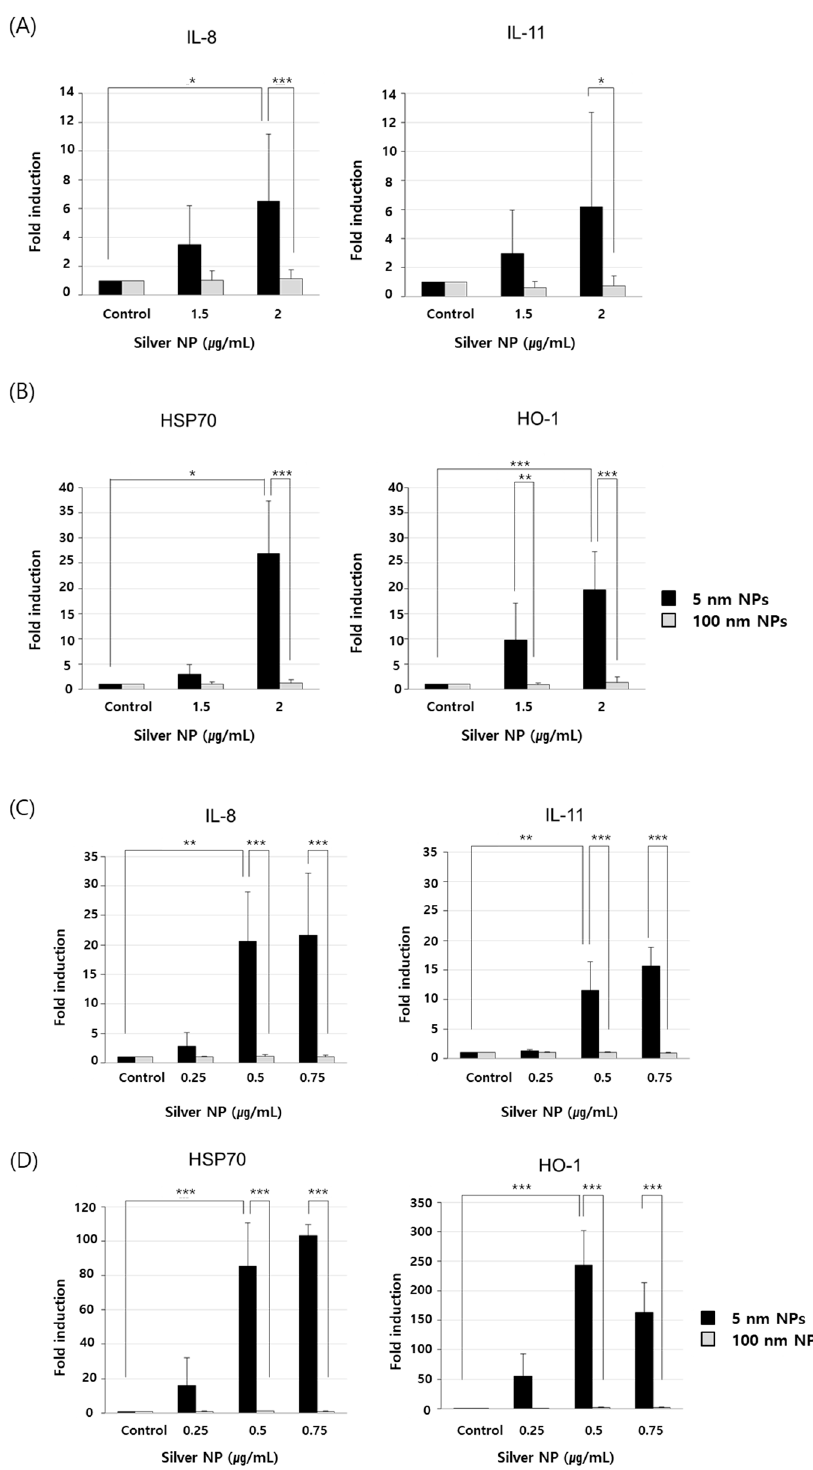
Figure 6. Expression of genes related to cytokine production and reactive oxygen species (ROS). ( A , B ) RT-PCR analysis was performed for EA.hy926 cells treated with silver NPs at 1.5 and 2 µg/mL for 6 h. ( C , D ) Real-time RT-PCR analysis was performed for BEAS-2B cells treated with silver NPs at 0.25, 0.5, and 0.75 µg/mL for 6 h. Data are shown as the mean ± standard deviation of three or more independent experiments. One-way and two-way analysis of variance was performed to determine the significance of the differences (* p < 0.05, ** p < 0.01, *** p < 0.001).